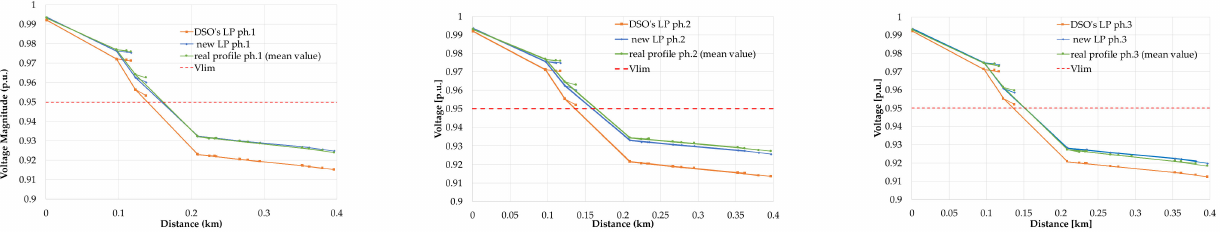
Figure 20. Voltage profile of feeder F_4 in one hourly interval: 6:00 p.m. of the winter working day (mean of real day values in green, DSO’s LPs in orange, and new LPs in blue; voltage limit in